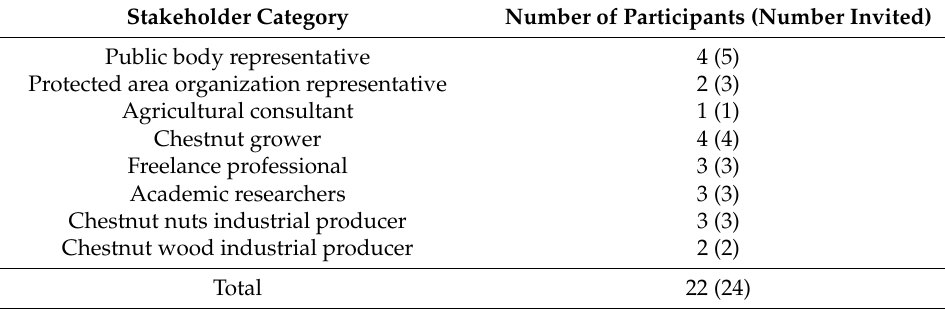
Table 1. Number of stakeholders involved in the focus